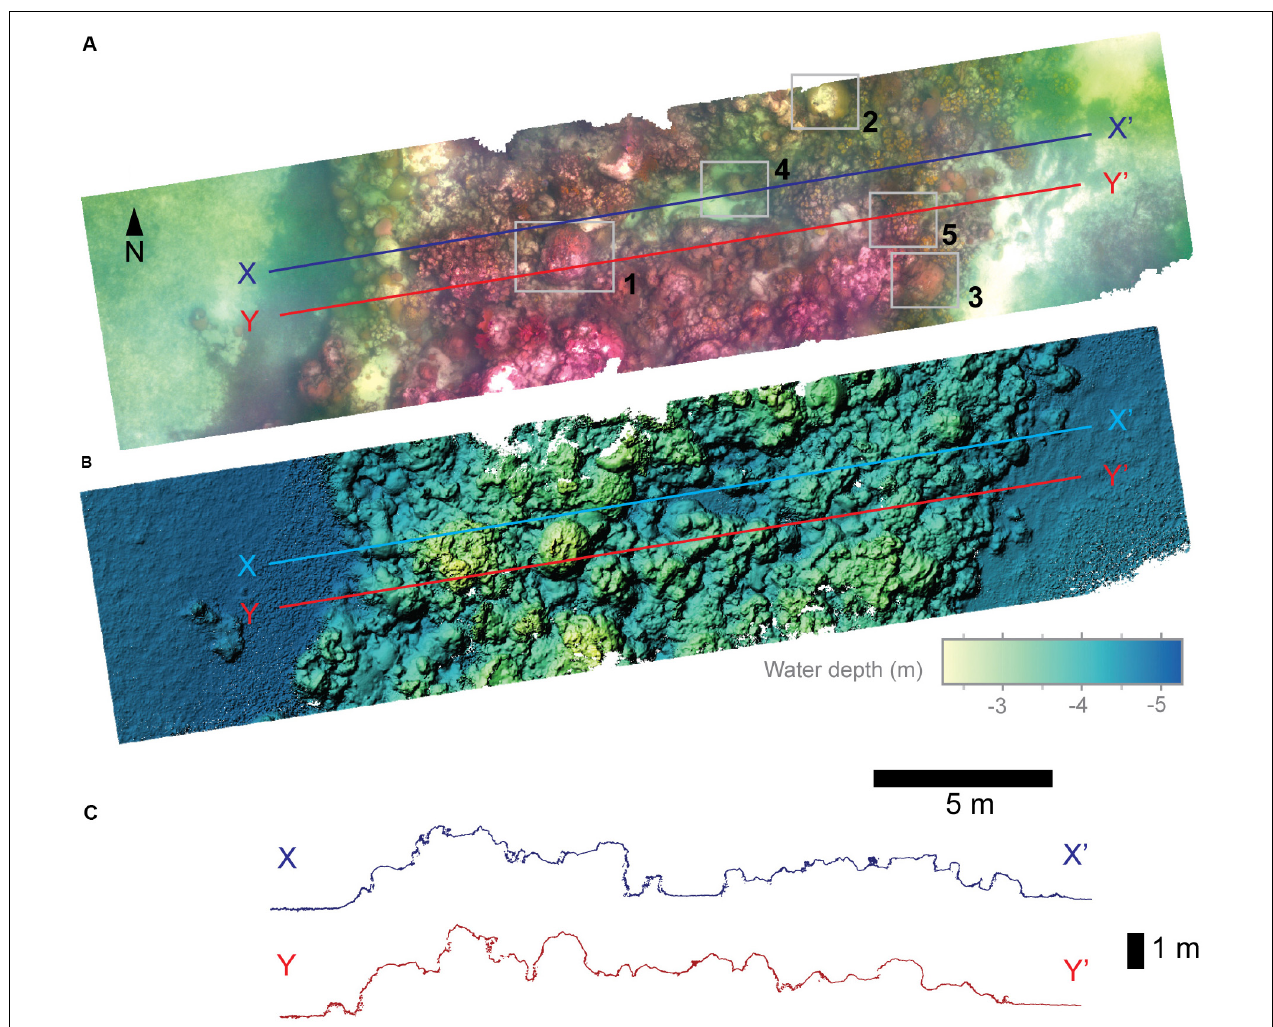
FIGURE 6 | (A,B) Mapped photo mosaic and bathymetry obtained from two survey passes of the Cheeca Rocks site with the SQUID-5 system. The shaded relief bathymetry is shown for a digital surface model (DSM) derived from the Structure-from-Motion (SfM) dense point cloud. The spatial resolution of the photo mosaic and DSM are 2.2 and 3.8 mm, respectively. (C) Elevation profiles of the Cheeca Rocks reef derived from the SfM dense point cloud. Locator boxes (1–5) are detailed in Figure 7